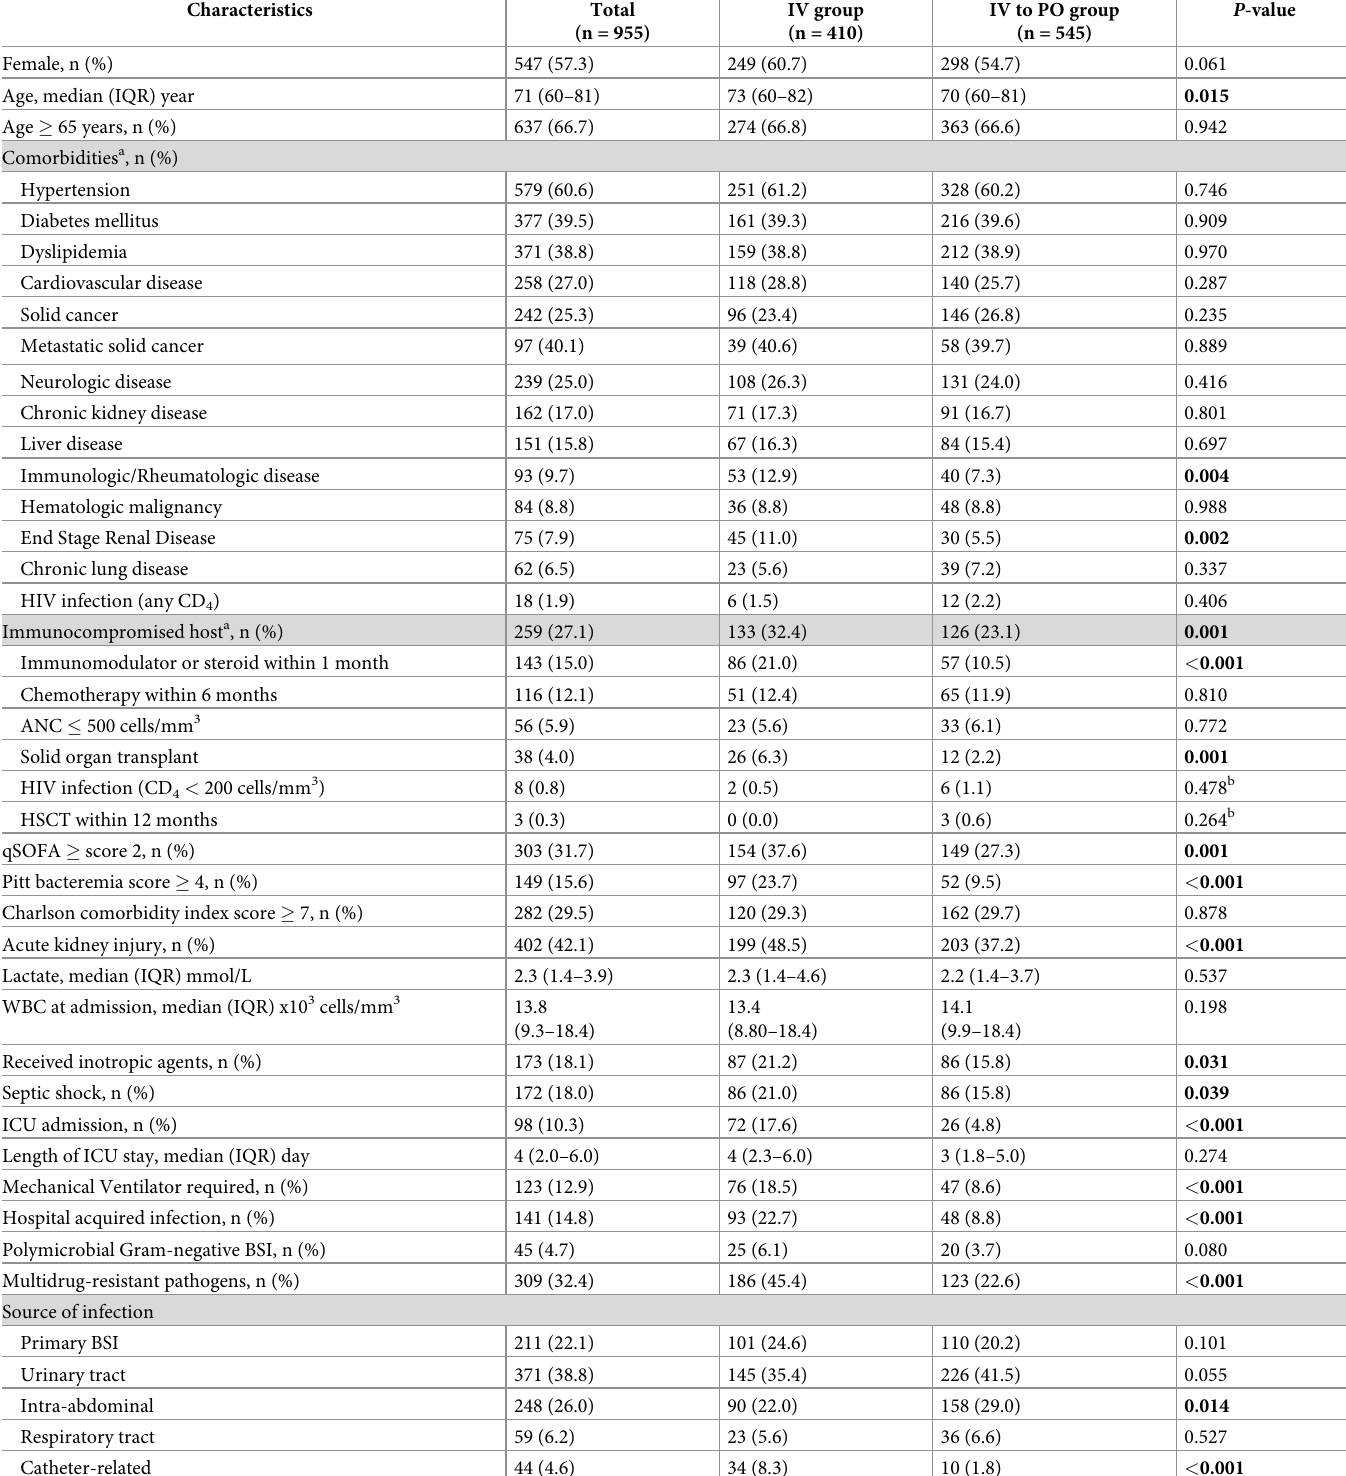
Table 1. Baseline characteristics of hospitalized patients with Gram-negative bloodstream infection continuing intravenous antibiotic agents or receiving intrave- nous to oral transition antibiotics (n = 955).